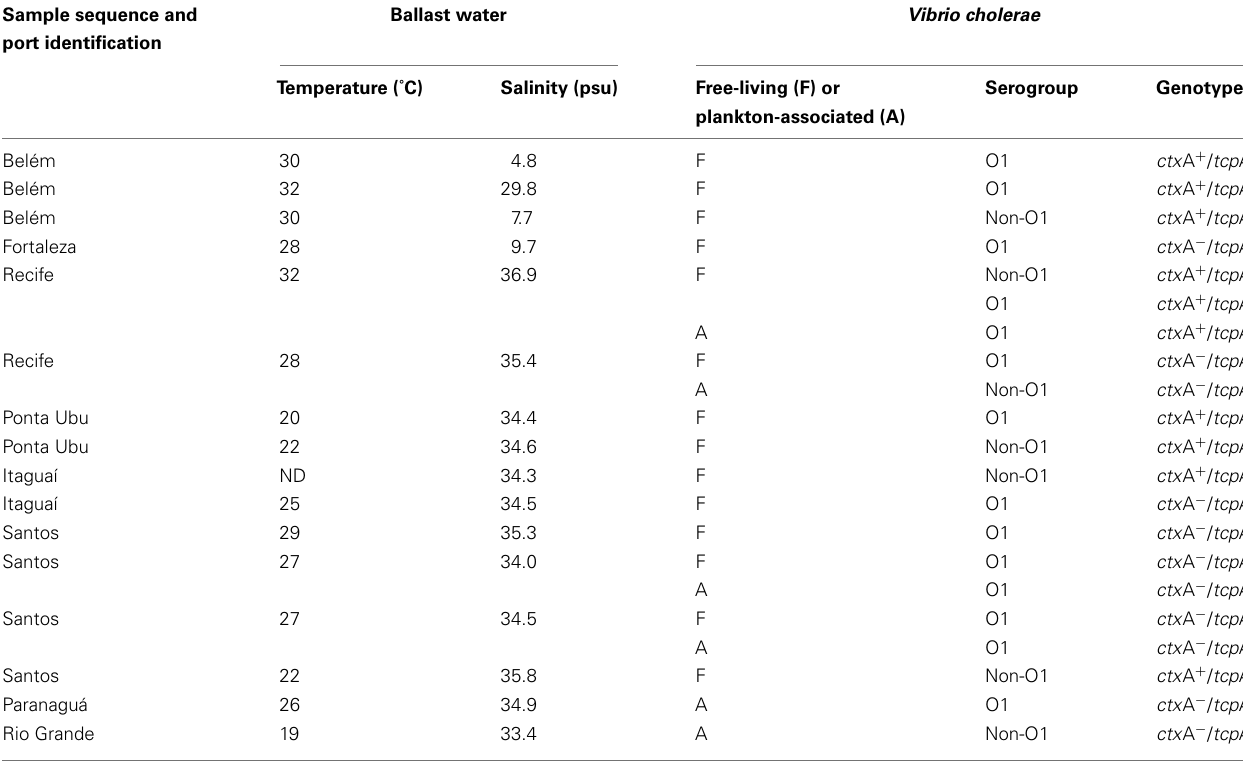
Table 1 | Characteristics of V. cholerae strains isolated from ballast water tanks of ships arriving in Brazilian ports, with temperature and salinity records.